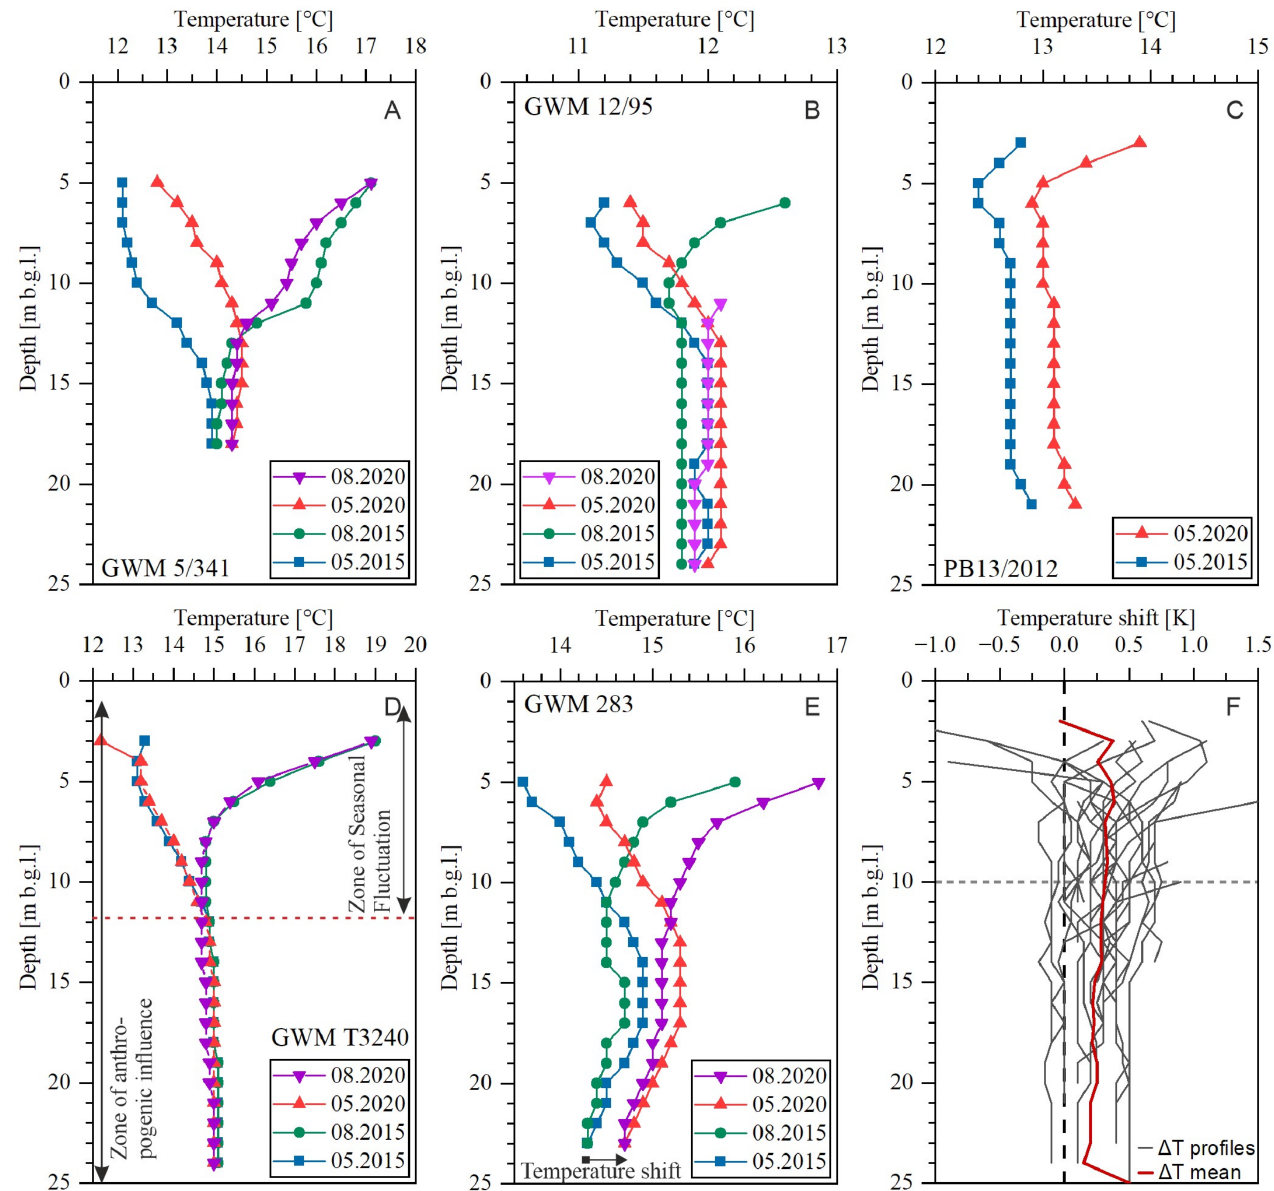
Figure 4. Comparison of different temperature–depth logs from five observation wells ( A – F ), recorded with the TLC-meter. A positive trend can be seen for the temperature profiles A – C and F . Temperature–depth log D shows constant temperatures over the entire observation period. In the case of the temperature–depth logs, only measurement series from the same months can be compared with each other, as otherwise temperature-related convections have too great an influence. Plot F shows the absolute temperature shift from 2015–2020 as a temperature–depth plot for each individual observation